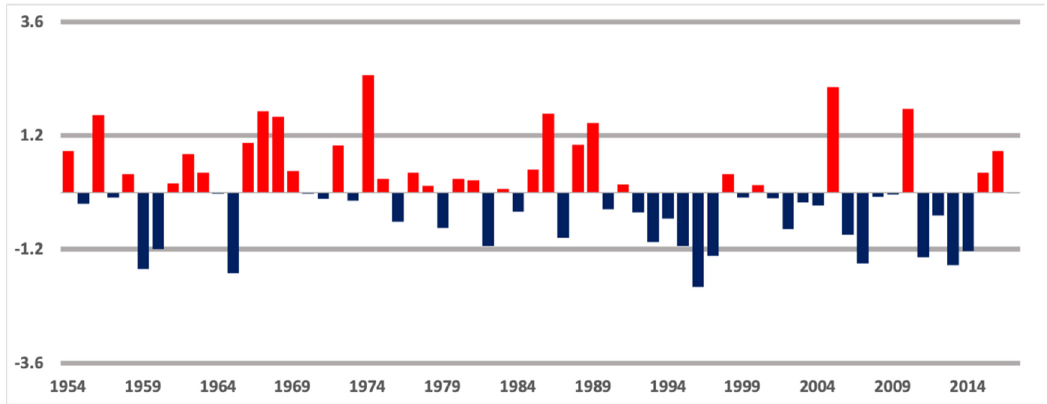
Figure 1. Standardized apparent heat source Q 1 of Qinghai-Tibet Plateau in December from 1954 to 2017.